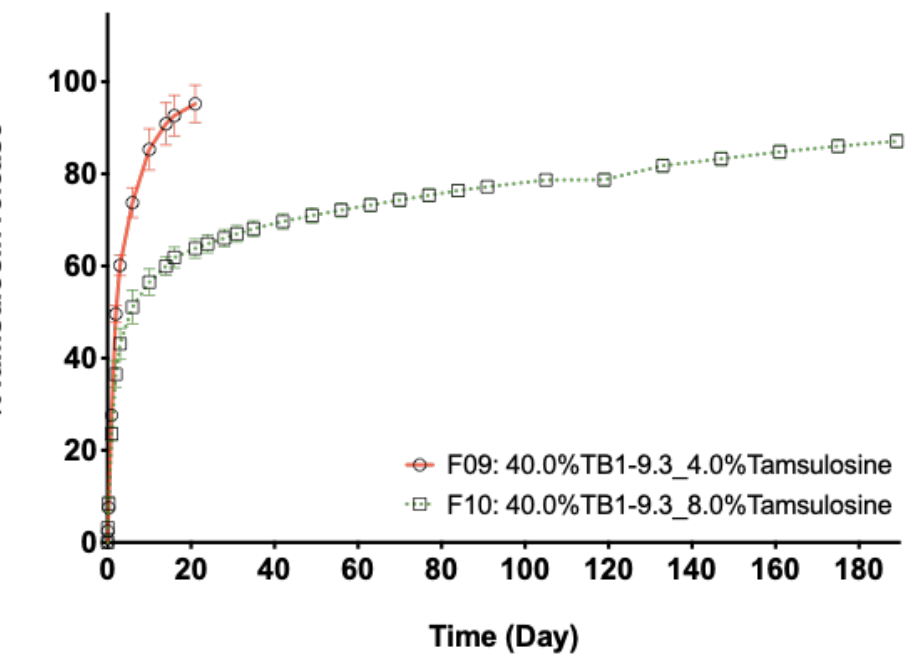
Figure 5. Tamsulosin release from PEG–PTMC solution (F09) and suspension (F10) formulations with the same type and content of triblock PEG–PTMC (TB1-9.3_40.0%).